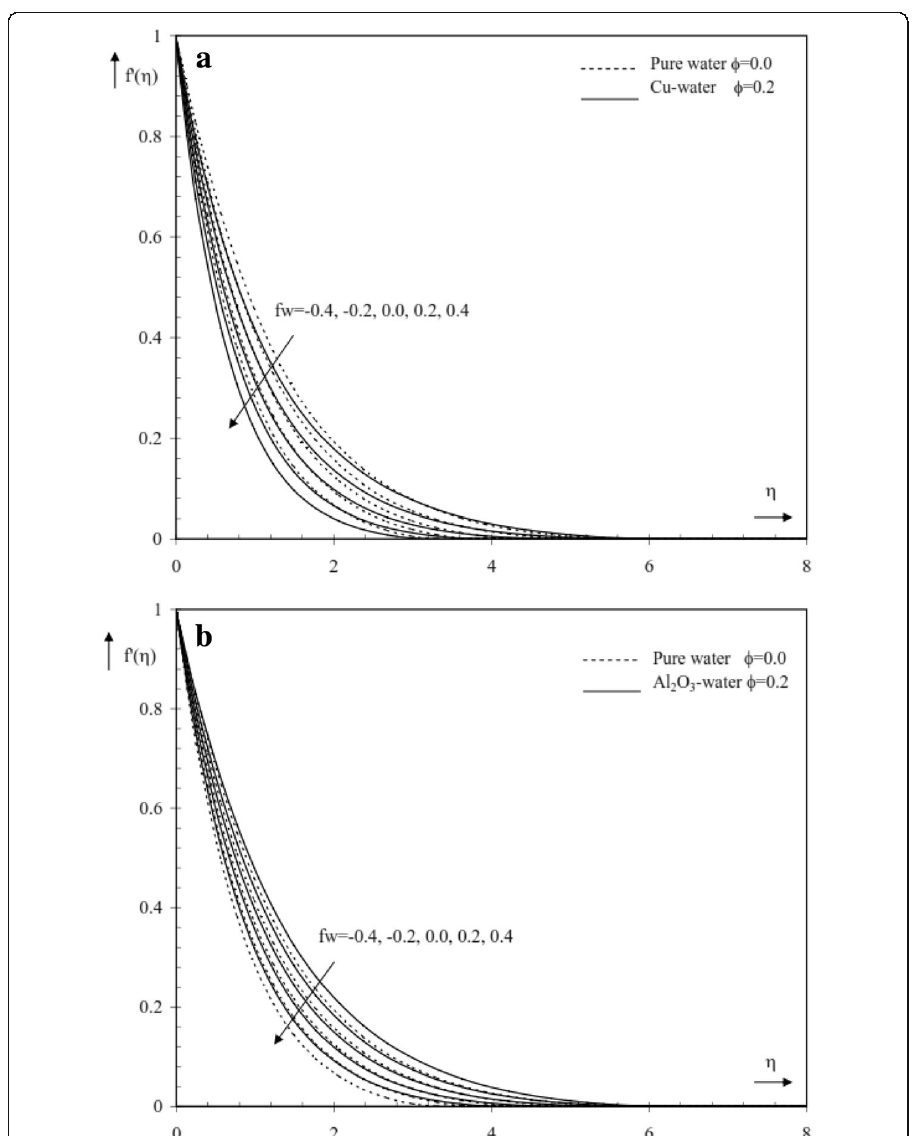
Fig. 7 Effects of ϕ and f w on velocity distribution f ′ ( η ) for S = M = 0.1 and A = B = λ = 0.5 for a Cu-water and b Al 2 O 3